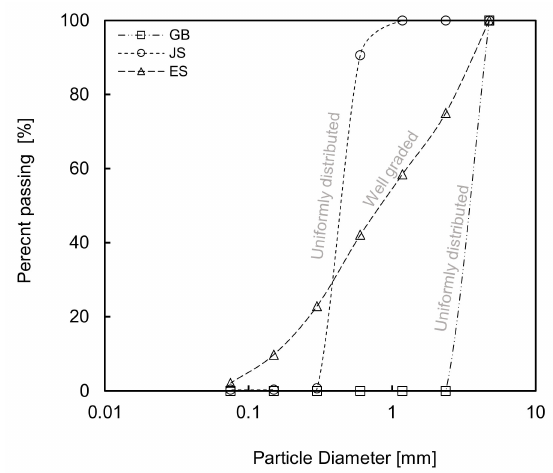
Figure 3. Results of sieve test for glass bead (GB), Jumunjin sand (JS) and extracted soil from field (ES).